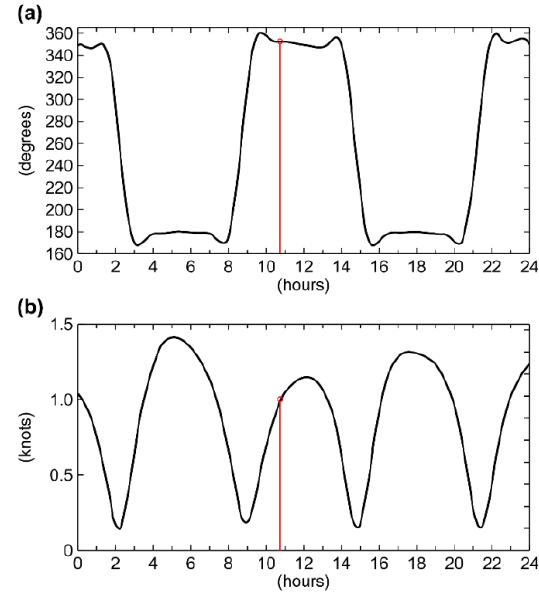
Figure 4. Target area and reference points.